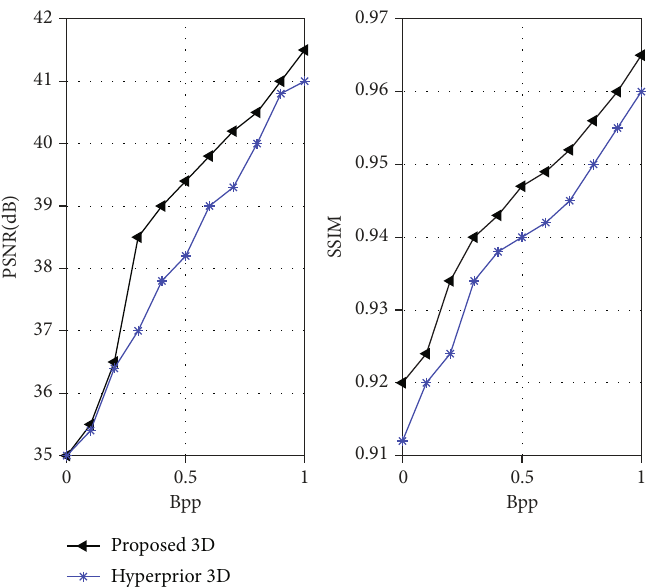
Figure 7: Comparison of results of 3D and 2D image modeling methods based on deep